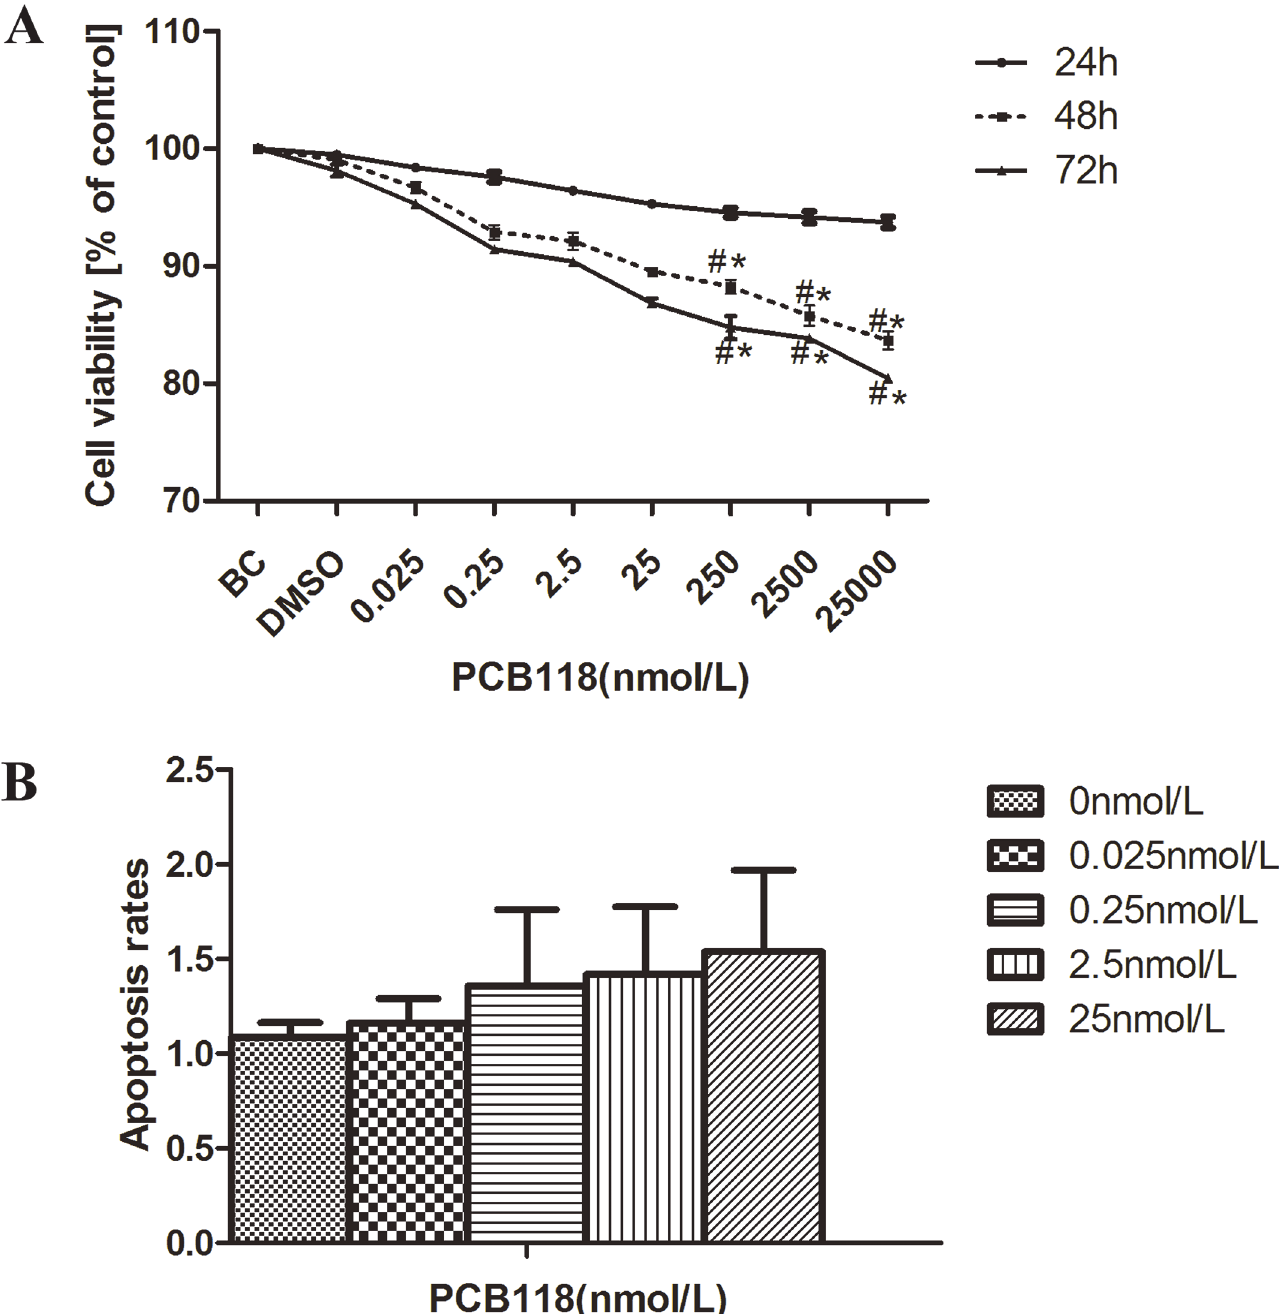
Fig 2. Effect of PCB118 on FRTL-5 cell viability and apoptosis. Cells were treated with PCB118 at different concentrations (0.025 – 25000 nM in the Cell Counting Kit-8 (CCK8) assay and 0.025 – 25 nM in the apoptosis assay). The viability was measured using the CCK-8 assay (A). The apoptosis rate was measured using a FACSVantage SE flow cytometer (B). Data are presented as the mean ± SD of three independent experiments. * p < 0.05, compared with the DMSO control group. # p < 0.05, compared with the low PCB118-treated groups (0.025, 0.25, 2.5, and 25 nM).